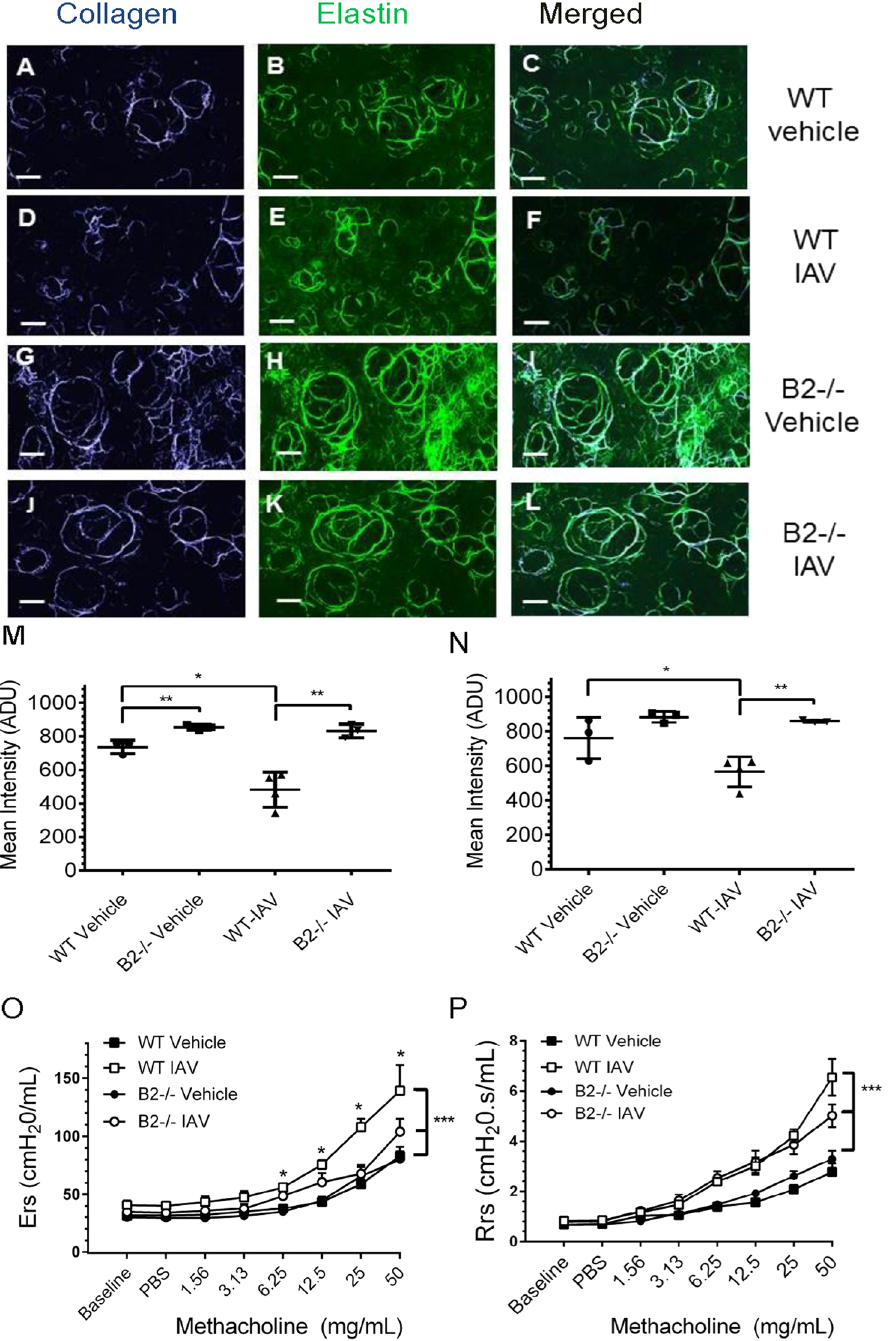
Figure 5. Endophilin B2 mediates disruption of alveolar wall matrix and development of respiratory disease after IAV infection. ( A–L ) Multiphoton microscopy was performed 14 days after intranasal administration of vehicle or IAV. Representative optically magnified SHG images originating from the alveolar collagen and elastin matrix are shown. The collagen (blue color) and elastic fibers (green color) are condensed around the alveolar wall in control lung tissues of both WT ( A–C ) and B2 − / − mice ( G–I ) treated with vehicle as well as in B2 − / − mice ( J–L ). Reduction of alveolar wall structures was evident only in WT lungs ( D–F ) 14 days after IAV infection. Scale bar: 51 μ m . ( M , N ) Volumetric quantitation of collagen ( M ) and elastin ( N ) fibers from 3-dimensional MPEF/ SHG image data sets were recorded from three different areas of WT and B2 − / − lungs ~600 μ m thick. The signal intensity for collagen was significantly reduced only in WT lungs 14 days after IAV infection compared to WT vehicle and IAV infected B2 − / − ( * p < 0.01 and ** p < 0.0029). Elastin was also significantly reduced compared to WT vehicle and IAV infected B2 − / − ( * p < 0.043 and ** p < 0.009, respectively). Collagen intensity was higher in vehicle B2 − / − compared to vehicle WT ( * p < 0.009). Data shown are means ± SD. ( O,P ) Respiratory elastance, Ers ( O ) and respiratory resistance, Rrs ( P ) data were acquired using a FlexiVent ventilator 14 days after administration of vehicle or IAV. * P < 0.001, and *** p < 0.0001, n = 4 per group. Data shown are means ±